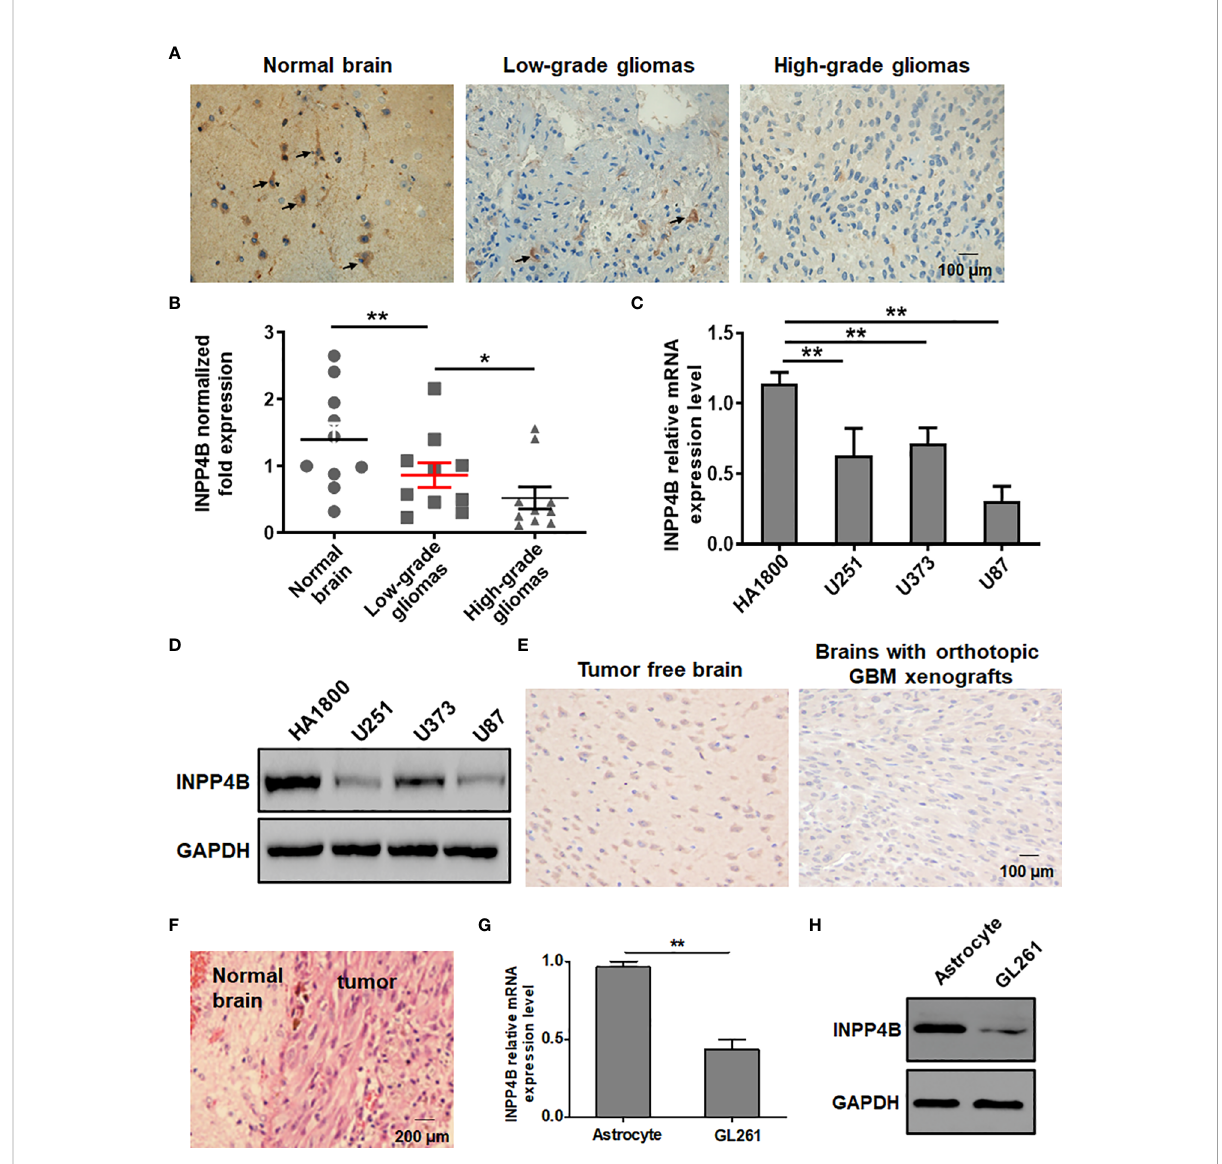
FIGURE 1 INPP4B expression is diminished in glioma tissues and cell lines. (A) IHC analysis of INPP4B expression in representative samples of normal brain tissues, and low- and high-grade glioma tissues. (B) Comparison of INPP4B mRNA levels in normal brain tissues (n = 10), low-grade glioma tissues (n = 10), and high-grade glioma tissues (n = 10). The relative abundance of INPP4B mRNA was calculated by reference to the amount of I NPP4B mRNA in normal brain tissues, arbitrarily assigned a value of 1. (C) Expression of INPP4B mRNA in a non-tumoral human astrocyte line (HA1800) and in three human glioma cell lines (U251, U373, and U87) assessed by qRT-PCR. (D) Western blot analysis of INPP4B protein expression in the same human cell lines as in (C) . (E) IHC analysis showing INPP4B expression in mouse orthotopic GBC xenografts brain tissues in comparison with normal brain tissues. (F) HE staining on a representative brain section from a mouse in which an orthotopic glioma xenograft was established successfully. (G, H) Expression of INPP4B in GL261 glioma cells and normal mouse astrocytes, assessed by qRT-PCR or western blot. Values represent the means ± SD (n = 3); * p < 0.05, ** p < 0.01. Scale bars, 100 m